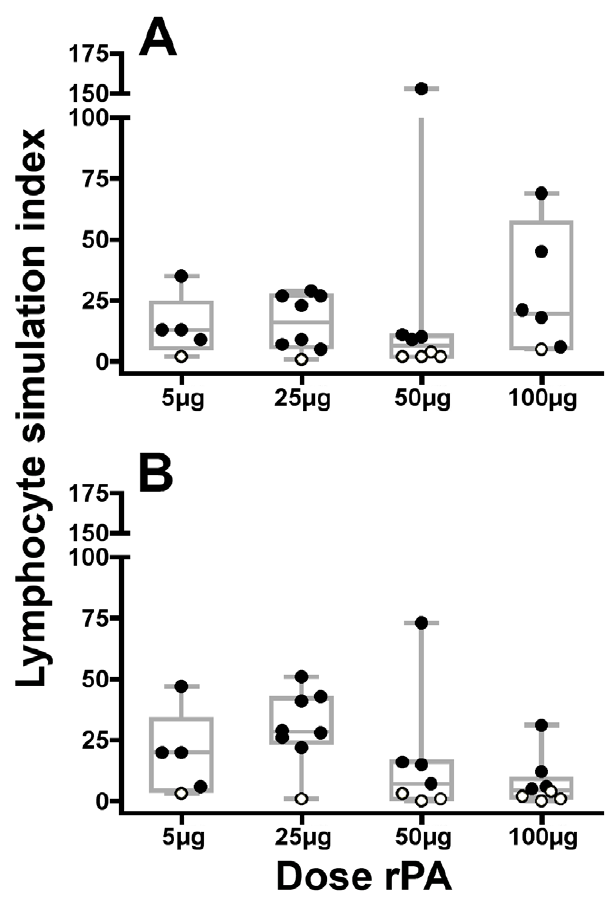
Figure 7. Vaccine induced lymphocyte proliferation. The LPA was performed on fresh cells obtained the day of the assay from participants at study visit 8 (2 weeks post second vaccination) incubated with 1 m g/ml of rPA. The resultant lymphocyte stimulation index (LSI) is plotted for all rPA-receiving participants. The individual data points are overlaid on box and whiskers plots, which show the median and percentiles for the data within each group. (A) Individuals whom received rPA formulated without Alhydrogel H adjuvant (PBS). (B) Individuals whom received rPA formulated with Alhydrogel H . Negative values (LSI # 5) are denoted by open